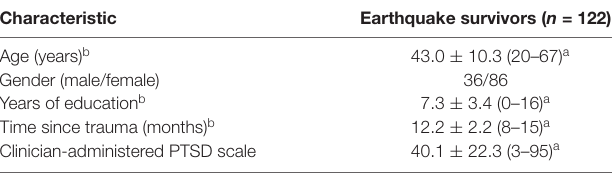
TABLE 1 | Demographics and clinical characteristics of the